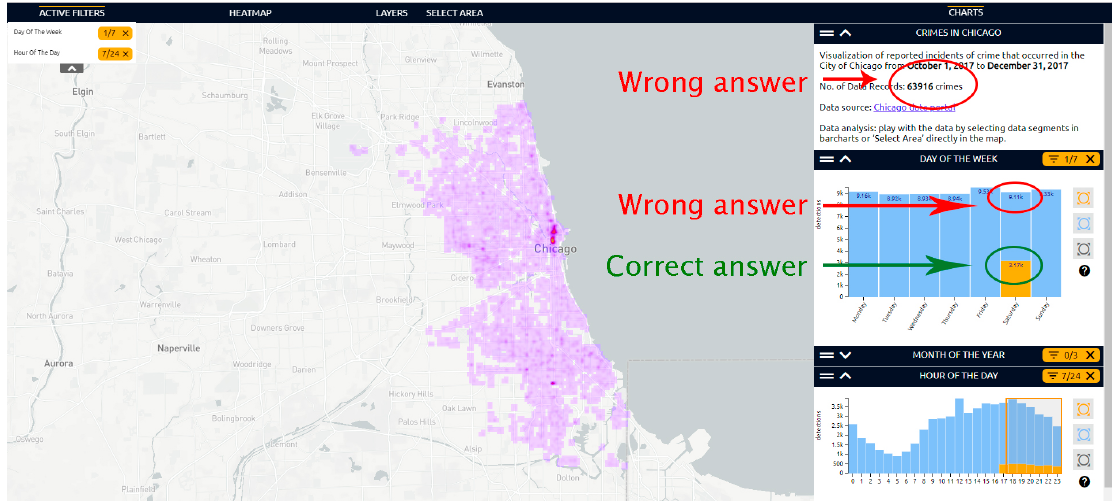
Figure 10. Correct and wrong answers to Task 3 in the Chicago map.